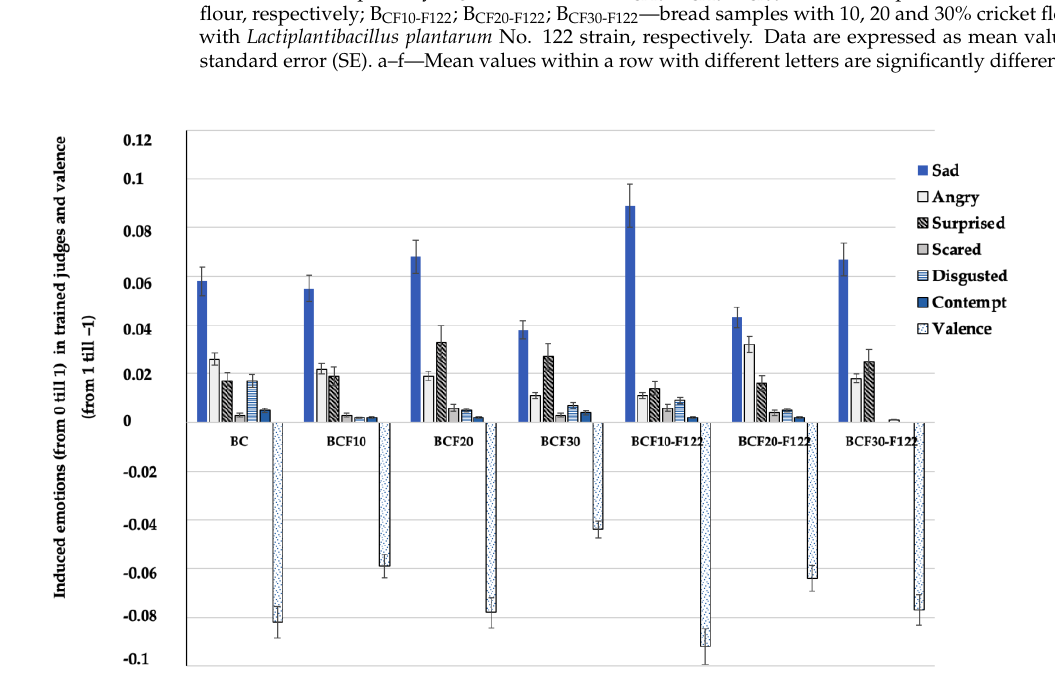
Figure 4. Intensity of induced emotions (“Sad”, “Angry”, Surprised”, “Scared”, “Disgusted”, “Con- tempt”) in trained judges and valence. B C — control bread; B CF10 ; B CF20 ; B CF30 — bread samples with 10, 20, and 30% cricket flour, respectively; B CF10-F122 ; B CF20-F122 ; B CF30-F122 — bread samples with 10, 20, and 30% cricket flour fermented with Lactiplantibacillus plantarum No. 122 strain, respectively. Data are expressed as mean values ( n = 10) ± standard error